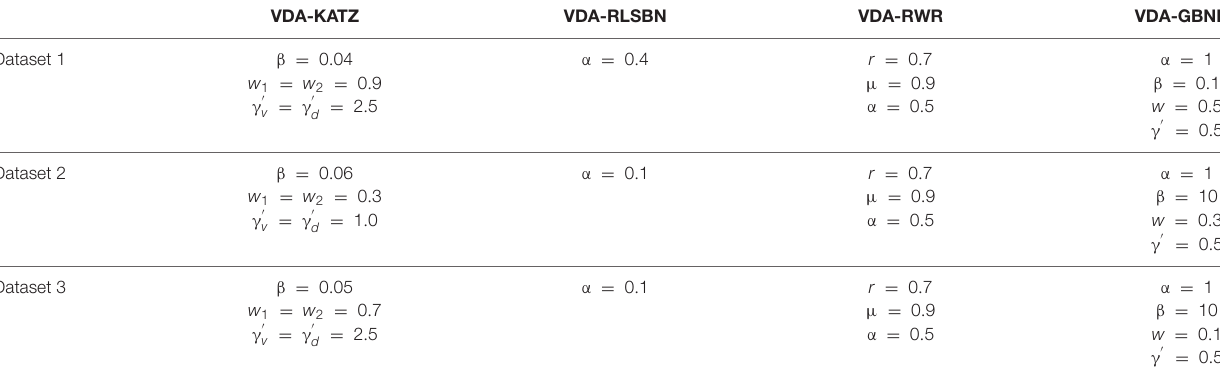
TABLE 3 | Optimal parameter settings for different models.